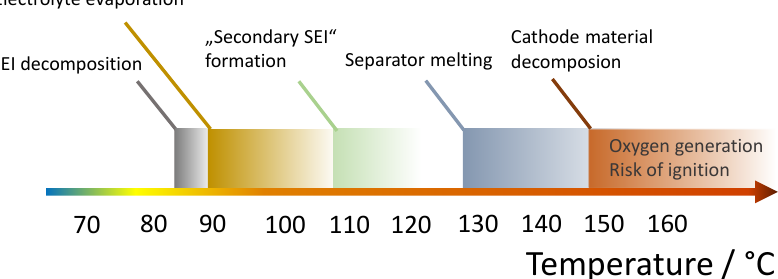
Figure 1. Degeneration effects of lithium-ion batteries at high temperatures.